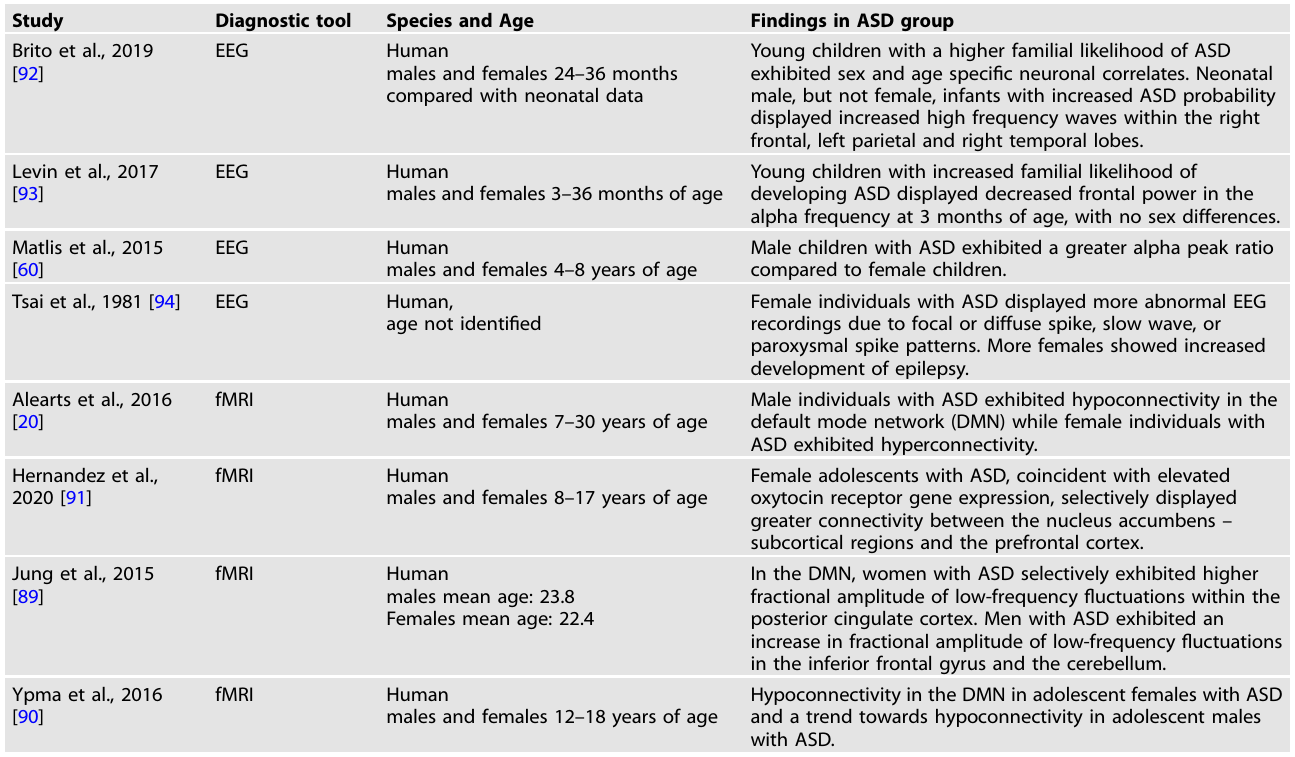
Table 1. Research incorporating sex differences in neuronal oscillations in ASD. Study male, but not female, infants with increased ASD probability displayed increased high frequency waves within the right frontal, left parietal and right temporal lobes. Human Young children with increased familial likelihood of males and females 3 – 36 months of age developing ASD displayed decreased frontal power in the alpha frequency at 3 months of age, with no sex differences. Male children with ASD exhibited a greater alpha peak ratio compared to female children. Female individuals with ASD displayed more abnormal EEG recordings due to focal or diffuse spike, slow wave, or paroxysmal spike patterns. More females showed increased development of epilepsy. Human Male individuals with ASD exhibited hypoconnectivity in the males and females 7 – 30 years of age default mode network (DMN) while female individuals with ASD exhibited hyperconnectivity. Female adolescents with ASD, coincident with elevated oxytocin receptor gene expression, selectively displayed greater connectivity between the nucleus accumbens – subcortical regions and the prefrontal cortex. Human In the DMN, women with ASD selectively exhibited higher males mean age: 23.8 fractional amplitude of low-frequency fl uctuations within the posterior cingulate cortex. Men with ASD exhibited an increase in fractional amplitude of low-frequency fl uctuations in the inferior frontal gyrus and the cerebellum. Human Hypoconnectivity in the DMN in adolescent females with ASD males and females 12 – 18 years of age and a trend towards hypoconnectivity in adolescent males with